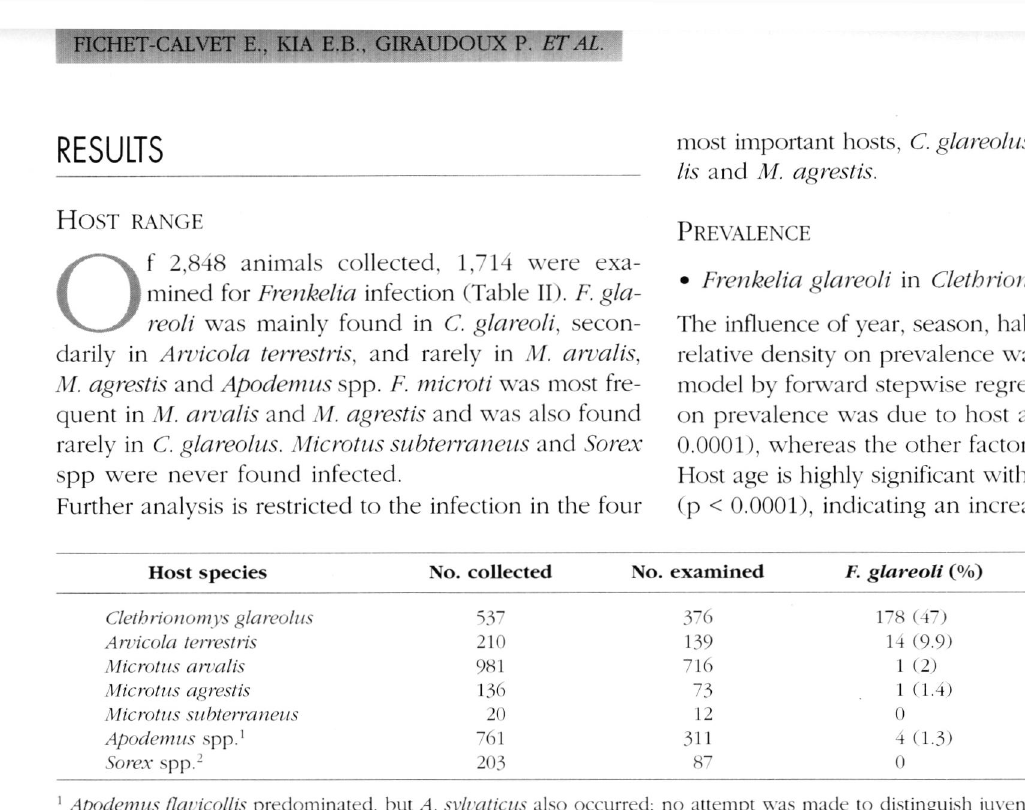
Fig. 2. - Prevalence of Frenkelia glareoli and abundance of its host Cletbrionomys glareolus (number of captures per 100 m of trap line) in the hedgerow network and in the forest. Numbers under each bar correspond to the rodents examined for infection.